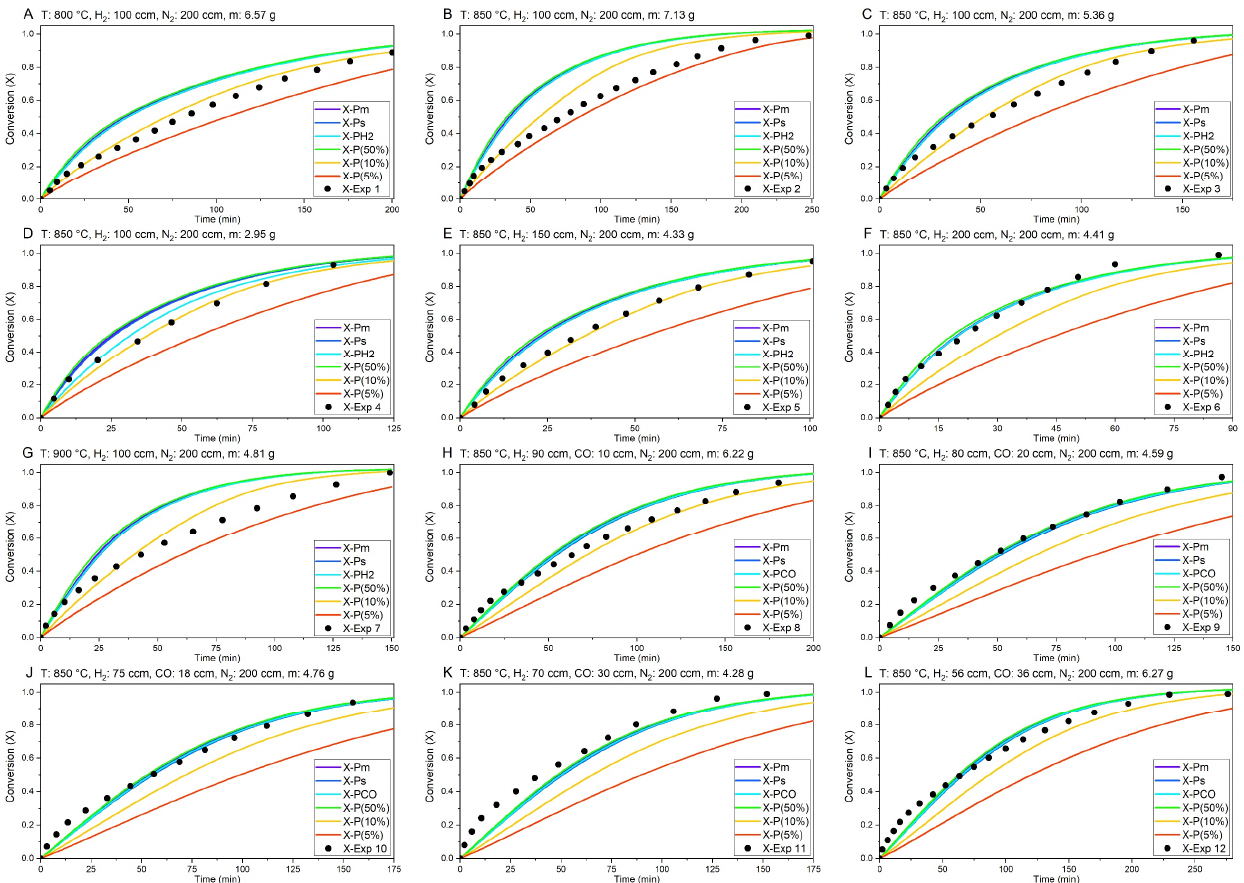
Figure 17. X vs. t curves obtained from the model (different porosity) and their validation with experimental data for ( A ) Experiment 1, ( B ) Experiment 2, ( C ) Experiment 3, ( D ) Experiment 4, ( E ) Experiment 5, ( F ) Experiment 6, ( G ) Experiment 7, ( H ) Experiment 8, ( I ) Experiment 9, ( J ) Experiment 10, ( K ) Experiment 11 and ( L ) Experiment 12.